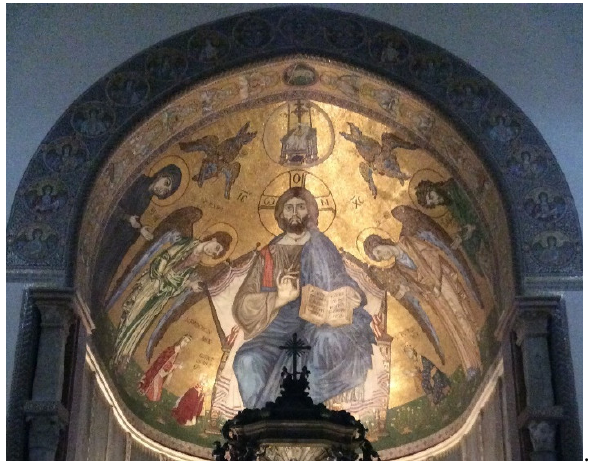
Figure 4. Cathedral of Messina, central apse with mosaic decoration rebuilt after the bombing on 13 June 1943. Photo taken by author.